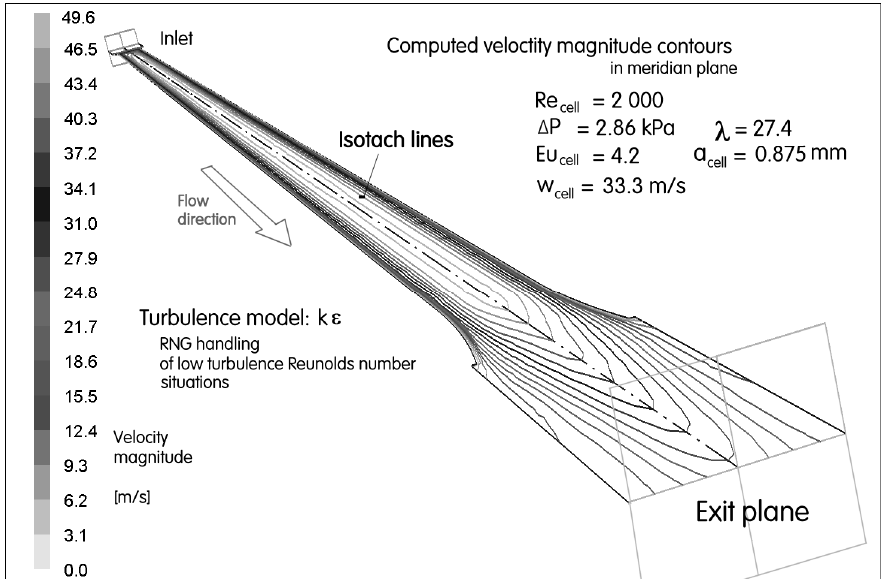
Figure 10. An example of the results of numerical flowfield computations: Distribution of absolute velocity contours in the meridian plane of the computation domain. Only the contours on the right of the axis was actually computed—the left side is a mirror image.